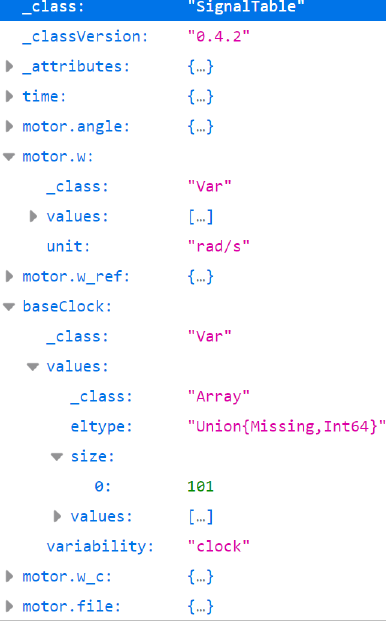
Figure 8. View of the file sigTable2.json in Firefox. The hierarchy of the JSON objects can be interactively expanded or